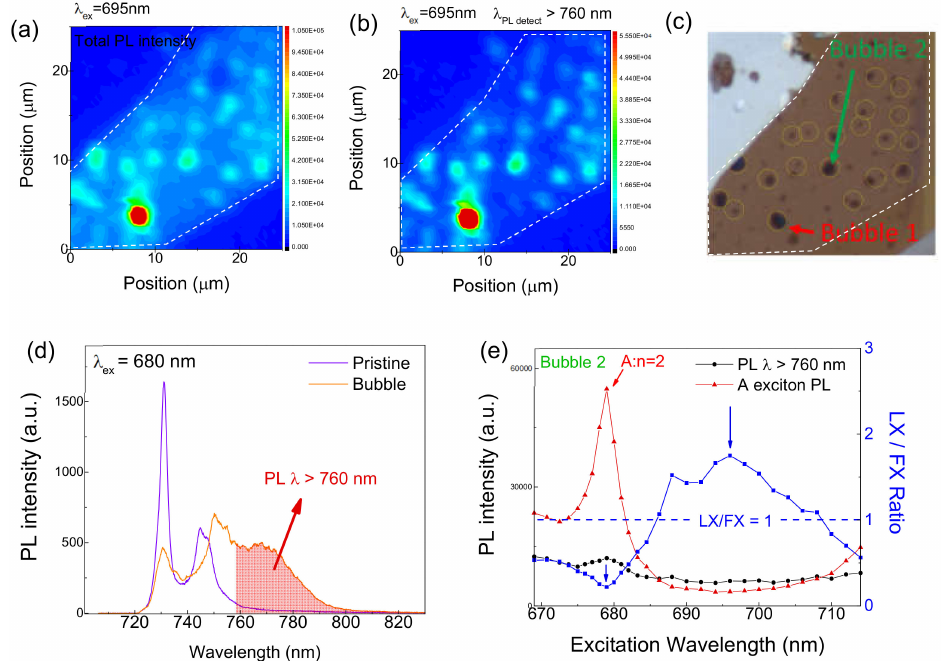
Figure 4. ( a ) Total PL intensity mapping of spatially enhanced LX emission using 695 nm excitation wavelength, and ( b ) PL intensity of λ detect > 760 nm mapping. ( c ) Microscopic image of the mapping area. ( d ) PL spectrum of WSe 2 ML from bubble 2 and a pristine site using 680 nm excitation wavelength. Area of λ detect > 760 nm is shown. ( e ) Excitation wavelength dependence of FX (red) and LX (black) intensity of WSe 2 ML for bubble 2. The LX / FX ratio is shown in